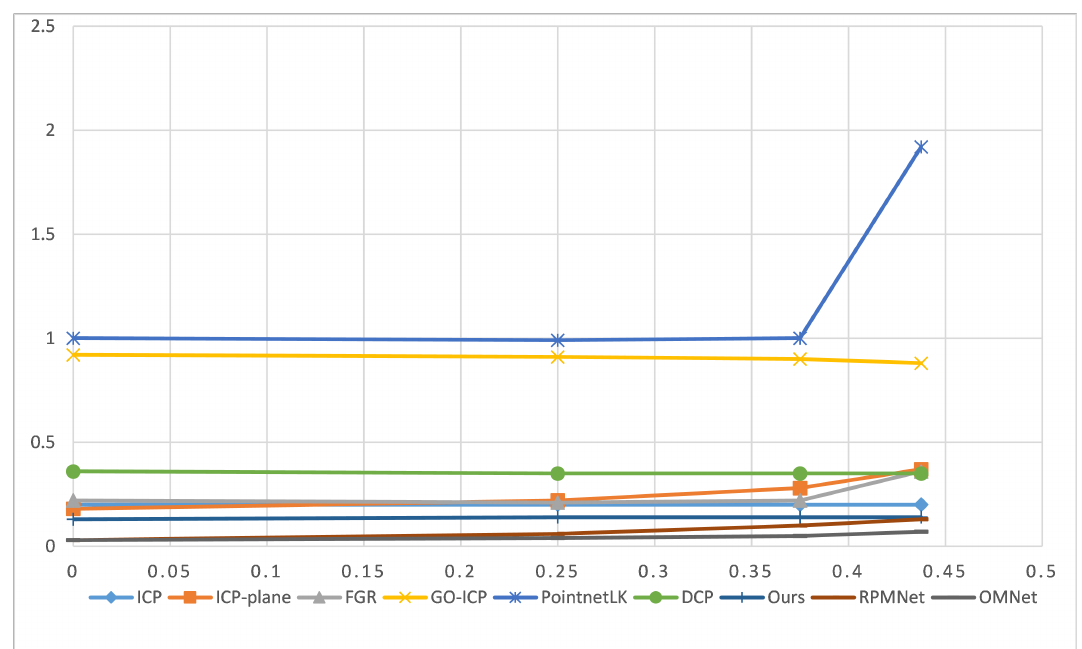
Figure 6. Influence of different sparsity levels on T _ loss